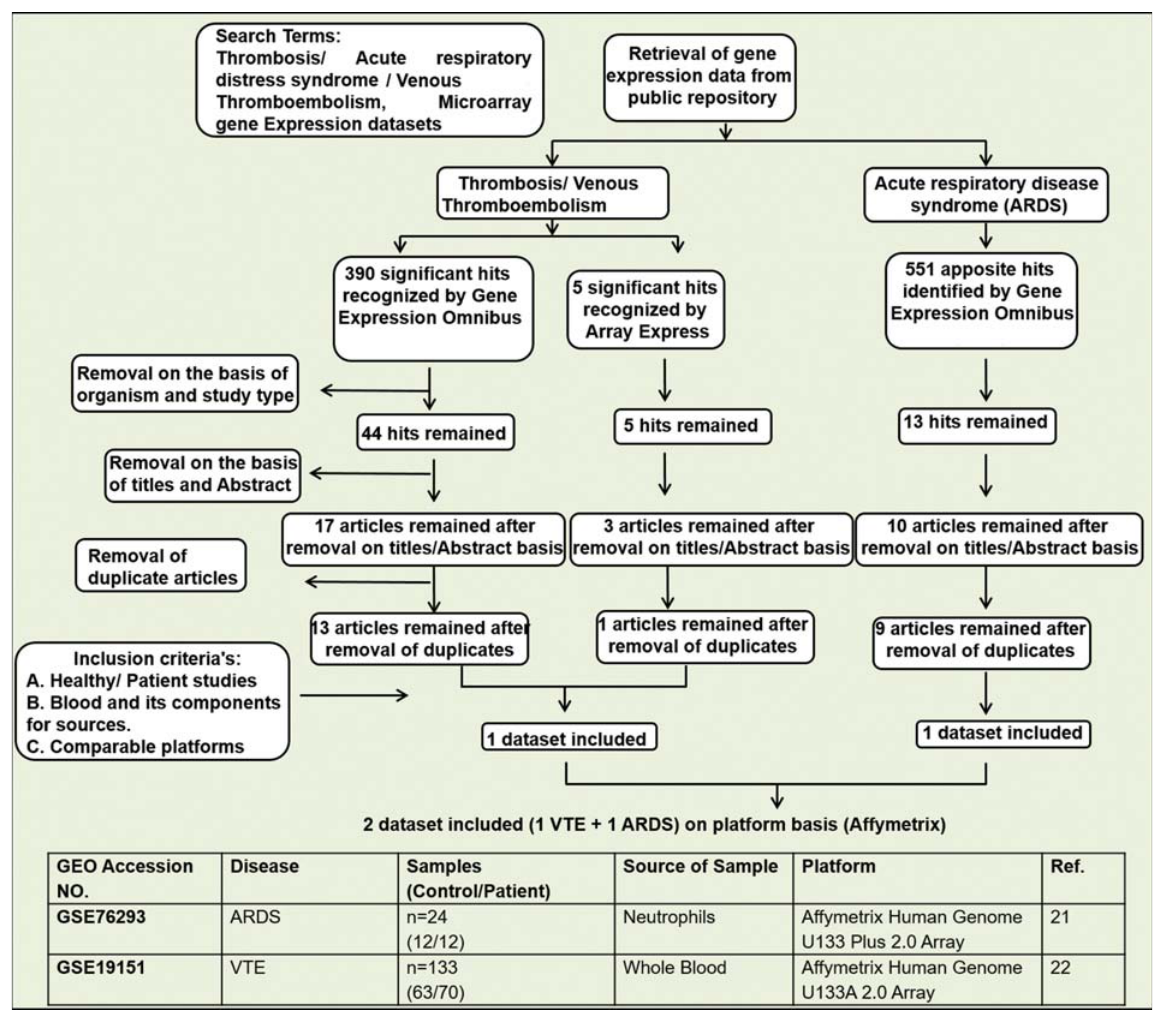
Fig. 1 Flow diagram depicting the selection of microarray meta-analysis and characteristics of individual studies included in the study. ARDS, acute respiratory distress syndrome, GEO, gene expression omnibus; VTE, venous